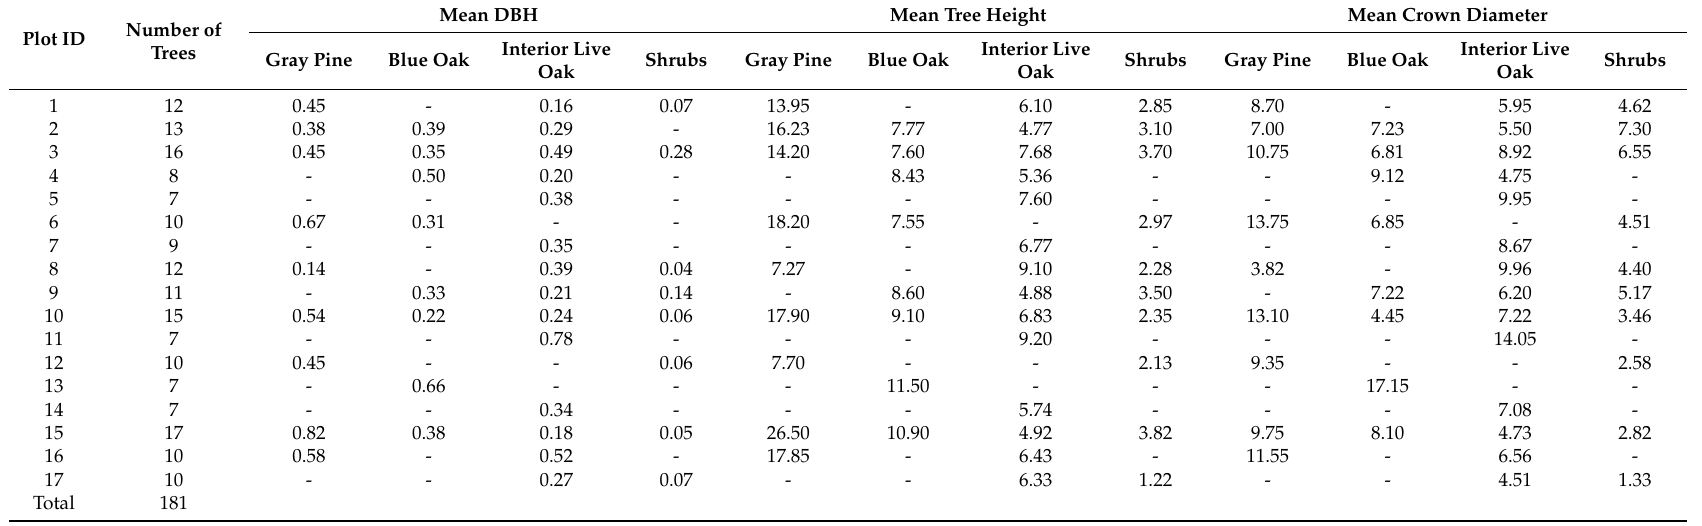
Table 1. Description of 17 field plots used for modeling building and calibration with the number of trees, mean diameter at the breast height (DBH, m), mean tree height (m) and mean crown diameter (m) over different tree